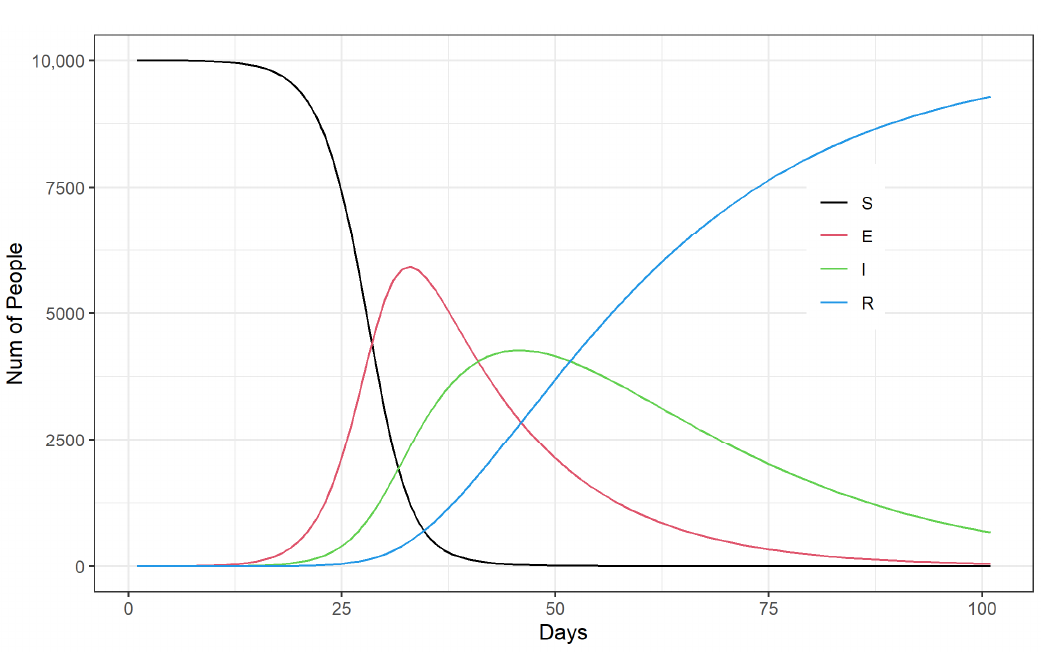
Figure A3. The influence of the daily testing capacity of 300 person on the evolutionary process of the epidemic; (The unit of the ordinate is “person”).